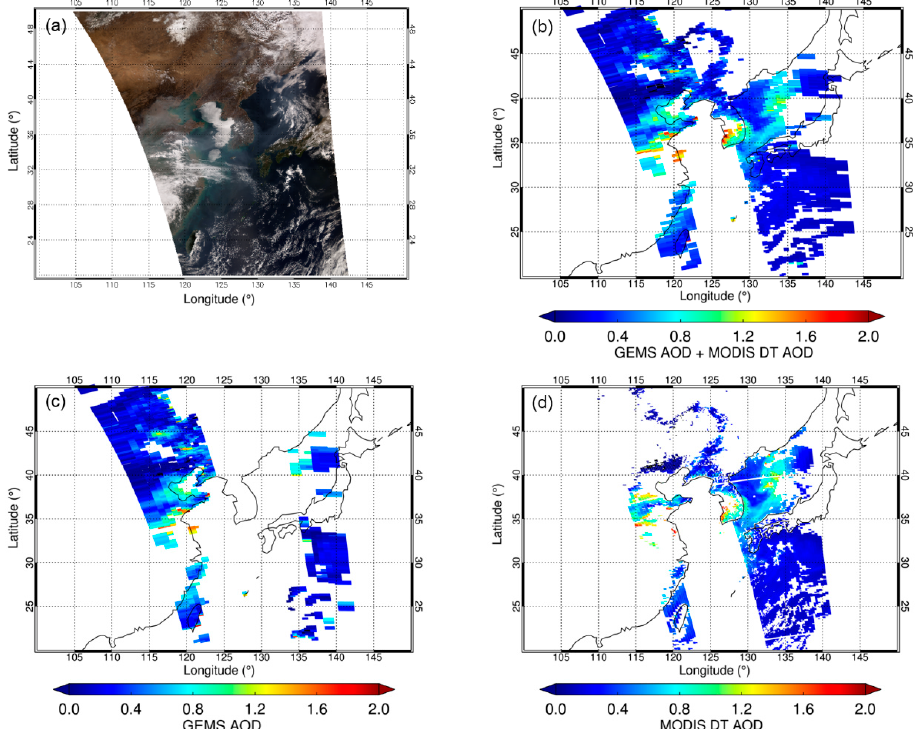
Figure 9. ( a ) MODIS RGB data for 24 March 2018. ( b ) Merged 550 nm AOD products for GEMS and MODIS DT AOD (C6.1) based on the maximum likelihood estimation (MLE) method. ( c ) GEMS 550 nm AOD products (using L1B of OMI as a proxy). The MODIS high-resolution cloud mask was used to screen cloud data in GEMS AOD. ( d ) MODIS DT 550 nm AOD (C6.1) product. Validation results for GEMS AOD (using OMI L1B as a proxy), MODIS DT AOD, and